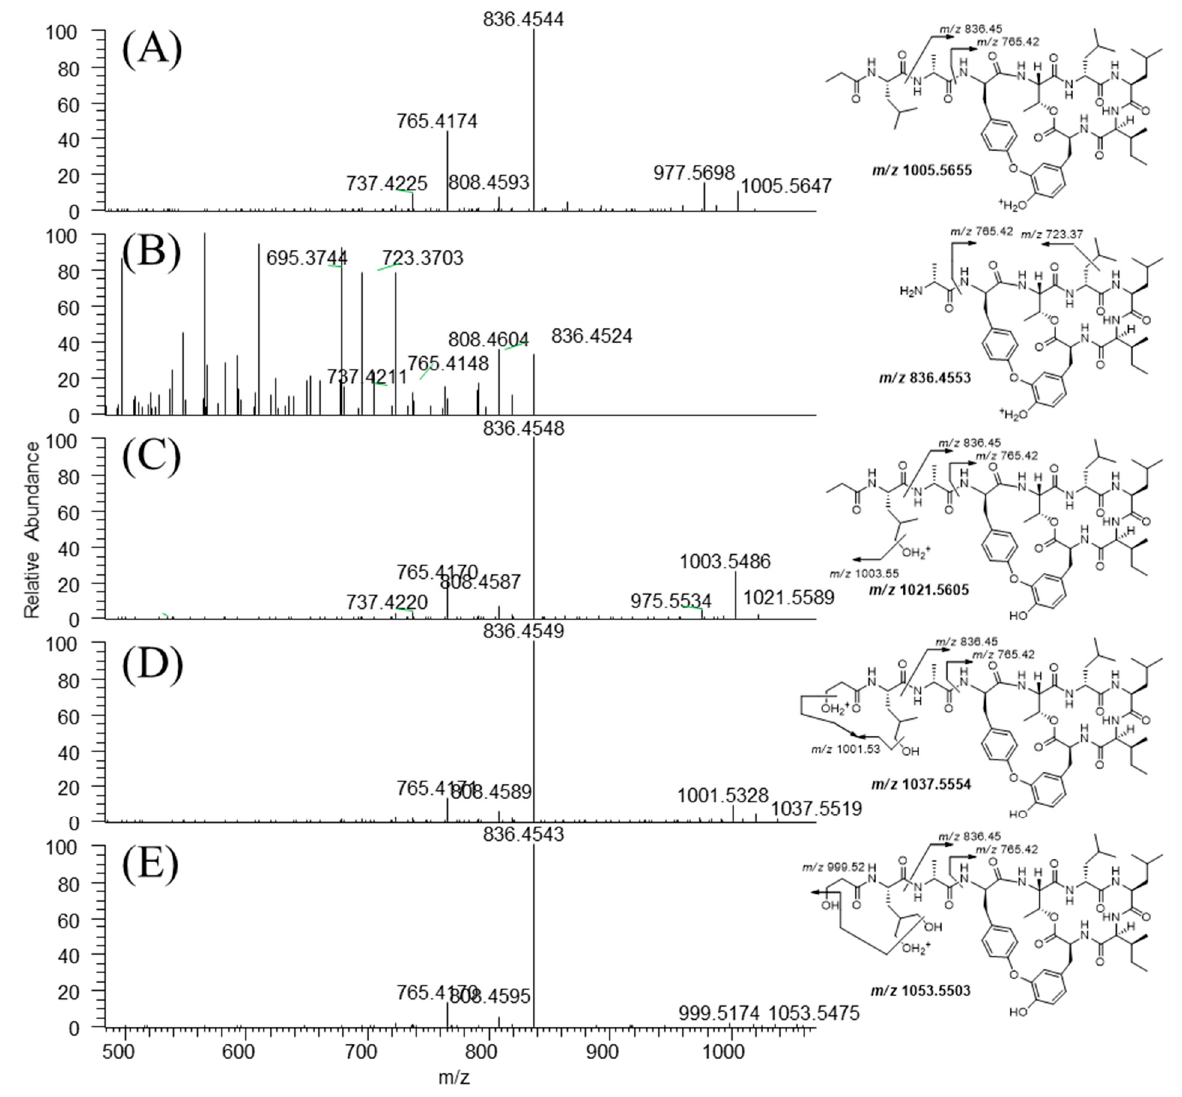
Figure 5. Representative product ion scan mass spectra and proposed fragmentation patterns of seongsanamide A ( A ), hydrolyzed seongsanamide A (M1), ( B ), Mono- (M2), ( C ), Di- (M3), ( D ), and tri-hydroxyseongsanamide A (M4), ( E ).